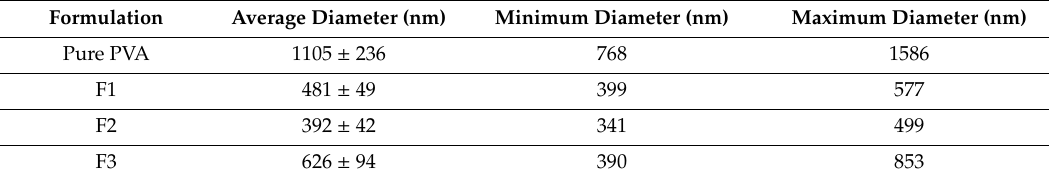
Figure 2. Viscosity of nonloaded and TE-loaded PVA solutions. * statistically significant, ** p < 0.01; *** p < 0.001 vs. pure PVA. Table 4. Fiber diameters of the obtained electrospun